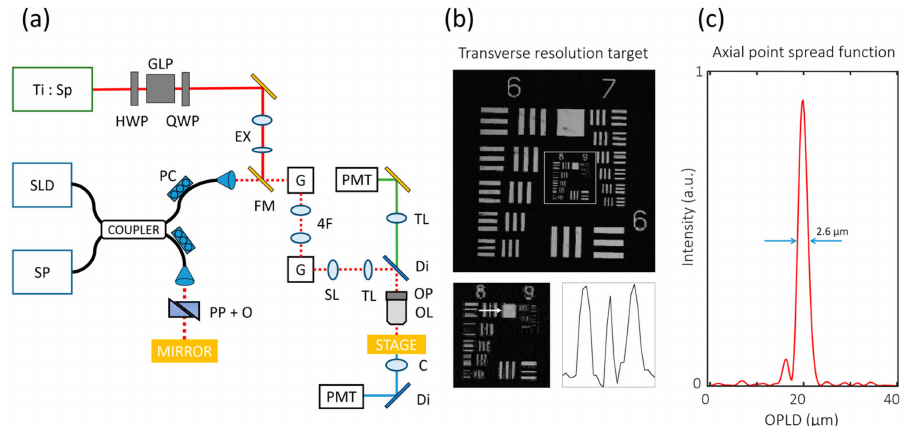
Figure 1. Graphical description of spectral domain Gabor-domain optical coherence microscopy (GD-OCM) system performance. ( a ) Schematics of GD-OCM with the second-harmonic generation microscopy (SHGM) system. ( b ) Transverse resolution measurement from the United states air force (USAF) 1951 resolution target. Element 1 in group 8 is the finest feature that can be resolved in both the X- and Y-axes. ( c ) The axial point spread function is 2.6 µ m in water (zero-padded 8 times). (Ti:SP: titanium sapphire laser; SLD: superluminescent diode; SP: spectrometer; GLP: Glan laser polarizer; PC: polarization controller; EX: beam expander; FM: flip mirror; G: galvanometer mirror; SL: scanning lens; TL: tube lens; PP + O: prism pair with other dispersive optics; Di: dichroic mirror; OP: objective lens positioner; OL: objective lens; C: condenser lens; PMT: photomultiplier tube; OPLD: optical pathlength di ff